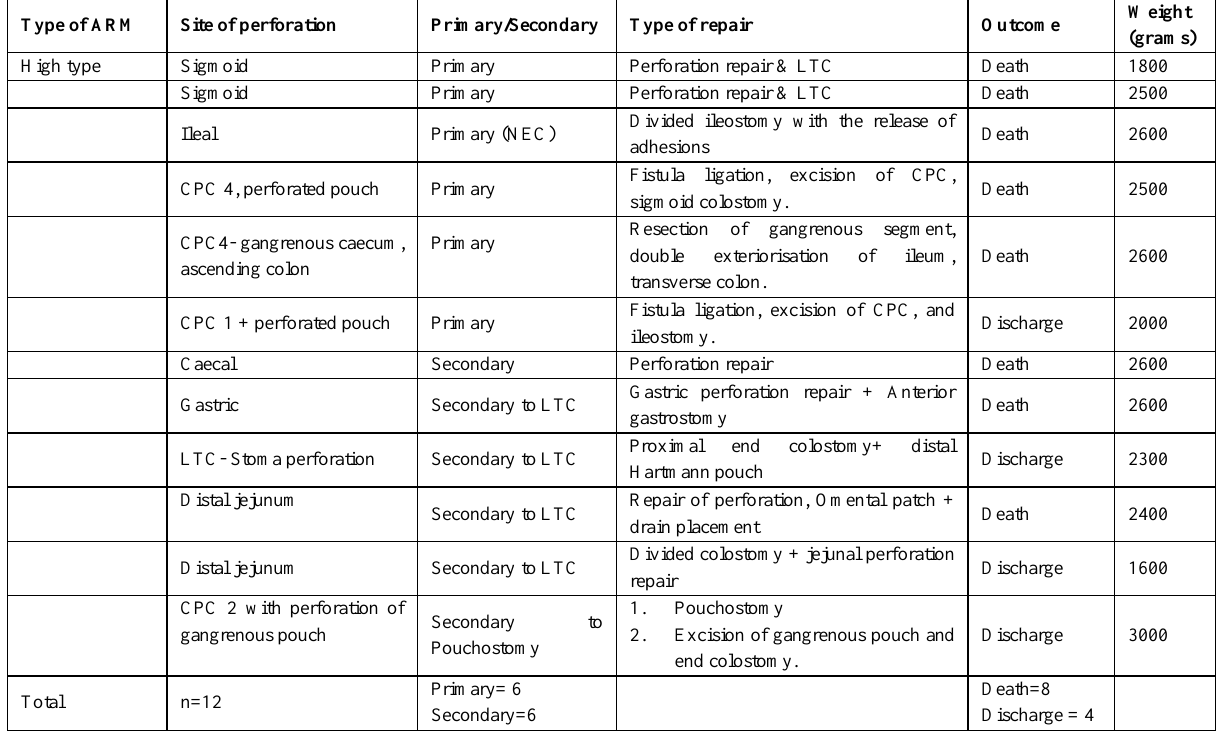
Table 6: Summary of gastrointestinal perforation in neonates with ARM, surgical intervention, and outcome. (LTC – Left transverse